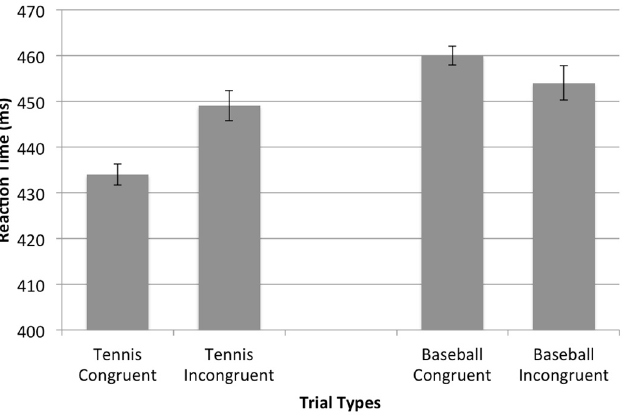
Fig 3. Skilled Reaction Times. Mean reaction times for skilled tennis players across both congruent and incongruent trials for tennis and baseball. Error bars represent standard error.